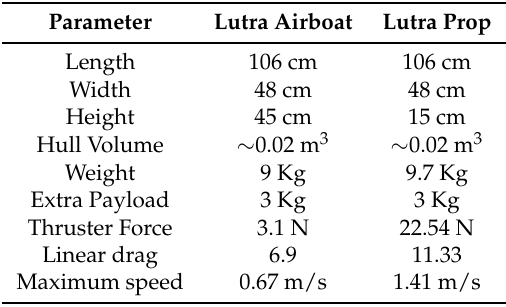
Table 2. Lutra Airboat and Lutra Prop